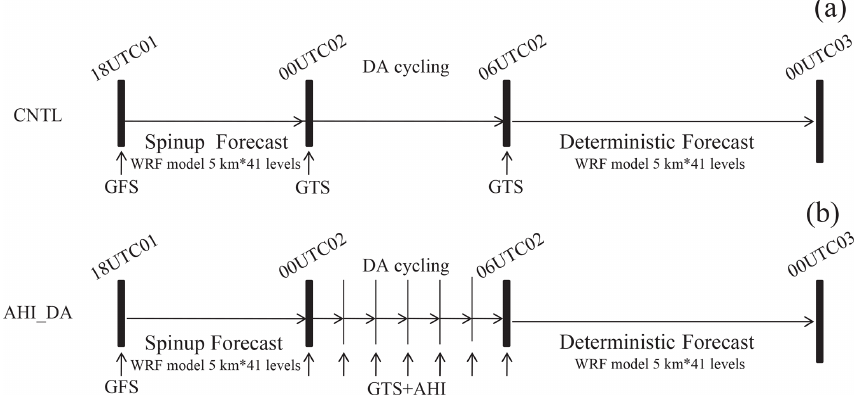
Figure 5. The flow chart of the data assimilation experiments. (a) CTNL, (b) AHI_DA.